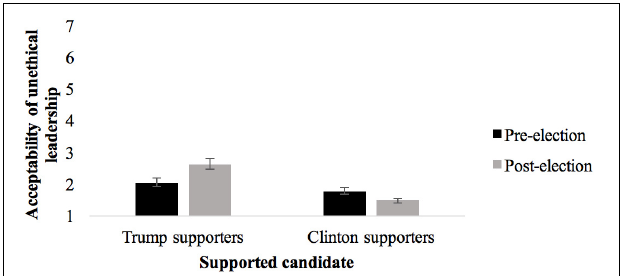
FIGURE 1 | Trump and Clinton supporters’ Acceptance of unethical Leadership Before and After 2016 US Presidential Election (means and standard errors).